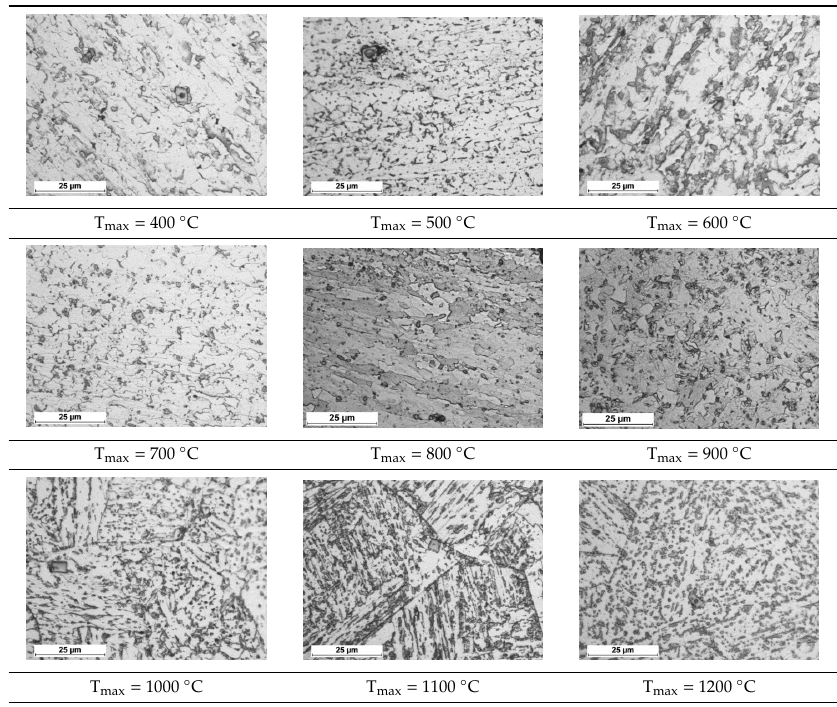
Figure 8. Comparison of ( a ) the registered and ( b ) the calculated thermal cycle as well as ( c ) the thermographic image and ( d ) the result of the numerical analysis in the form of temperature distribution for the thermal cycle with T max = 1200 °C.